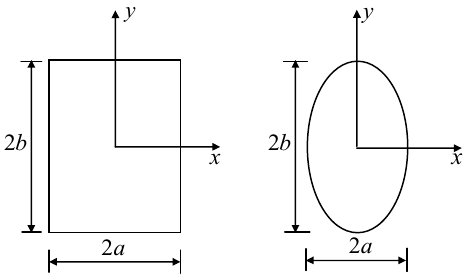
Fig. 4. A rectangular section used in example 1 and an elliptical section used in example